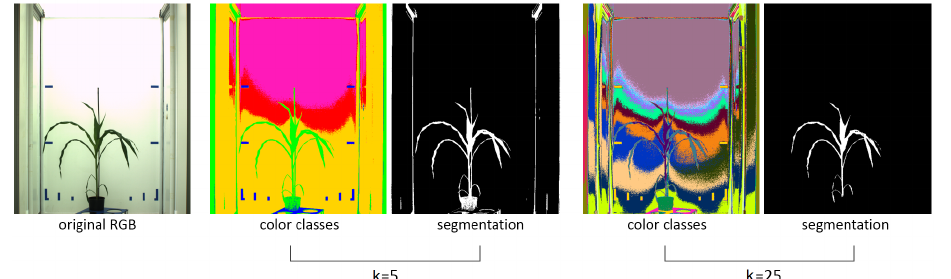
Figure 7. Automated segmentation of a maize shoot image into k = 5 and k = 25 k-means color classes. With the higher number of k-means classes a more accurate color separation of plant and non-plant structures was achieved. From left to right: original RGB image of a greenhouse-grown maize plant, quasi-color representation of k-means color classes as well the results of plant segmentation for k = 5 and k = 25,